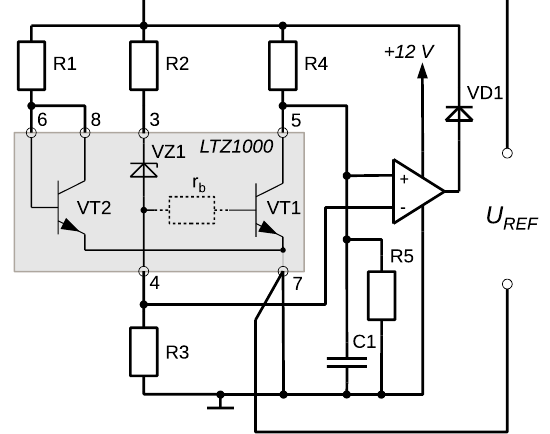
Figure 5. LTZ1000 voltage curvature